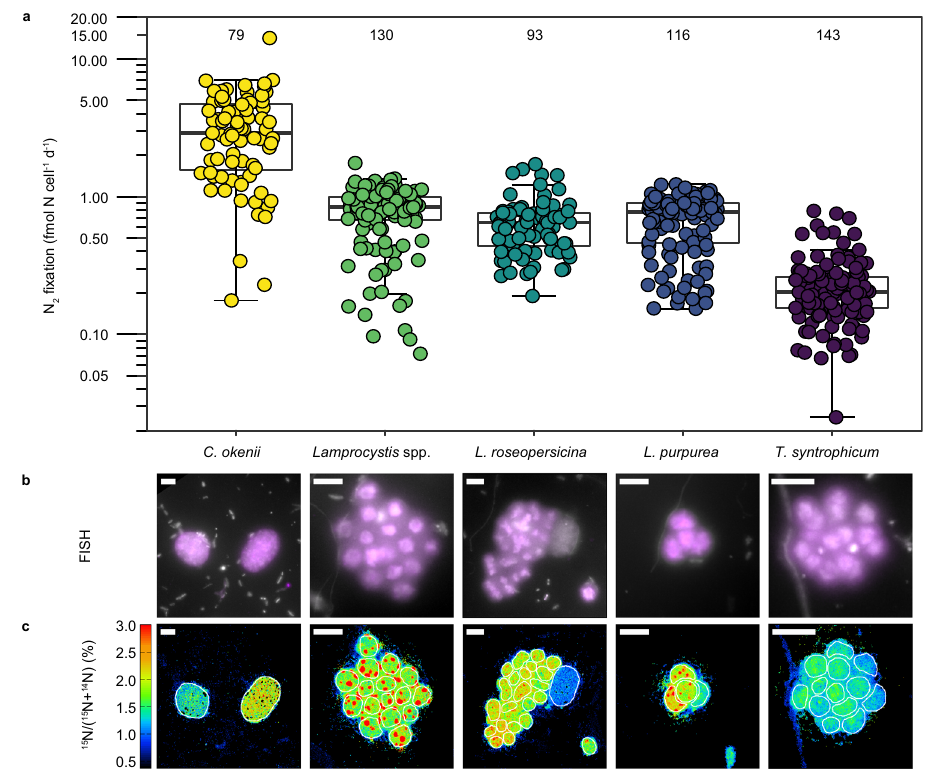
Fig. 4 Single cell N 2 fi xation activity determined by nanoSIMS. a Single-cell N 2 fi xation rates of individual PSB populations in 13.7m water depth. The number of cells analyzed per population ( n ) is shown above each box plot. Boxplots depict the 25 – 75% quantile range, with the centerline depicting the median (50% quantile); whiskers encompass data points within 1.5× of the interquartile range. Y -axis is in log scale. b Representative epi fl uorescence and c nanoSIMS images of the individual PSB populations. Scale bars ( b and c ) represent 4 µ m. Individual target PSB populations (in purple) were identi fi ed using speci fi c FISH probes. All cells were counterstained with DAPI (white). PSB in nanoSIMS images are outlined in white. Note the presence of one C. okenii cell in the L. roseopersicina images. For each population, four independent FISH experiments were conducted, with similar results as shown in panel ( b